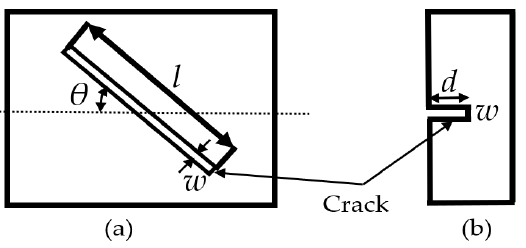
Figure 5. Schematic diagram of the crack in the tested sample: ( a ) plan view and ( b ) side view (not to scale).